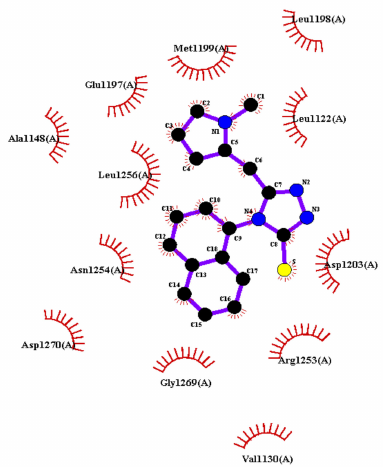
Figure 12. Hydrophobic interactions between titled organic ligand and amino acid